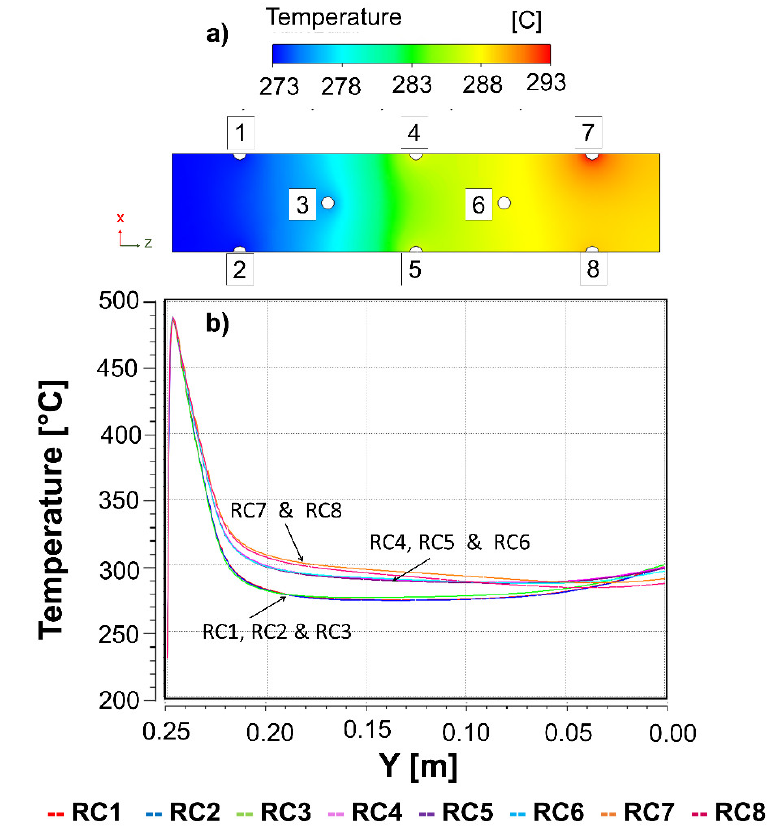
Figure 6. Temperature profiles of the ( a ) insulating material in the XZ plane performed at the middle reactor (125 mm); ( b ) each reactive channel along its Y height (0–250). reactor (125 mm); ( b ) each reactive channel along its Y height